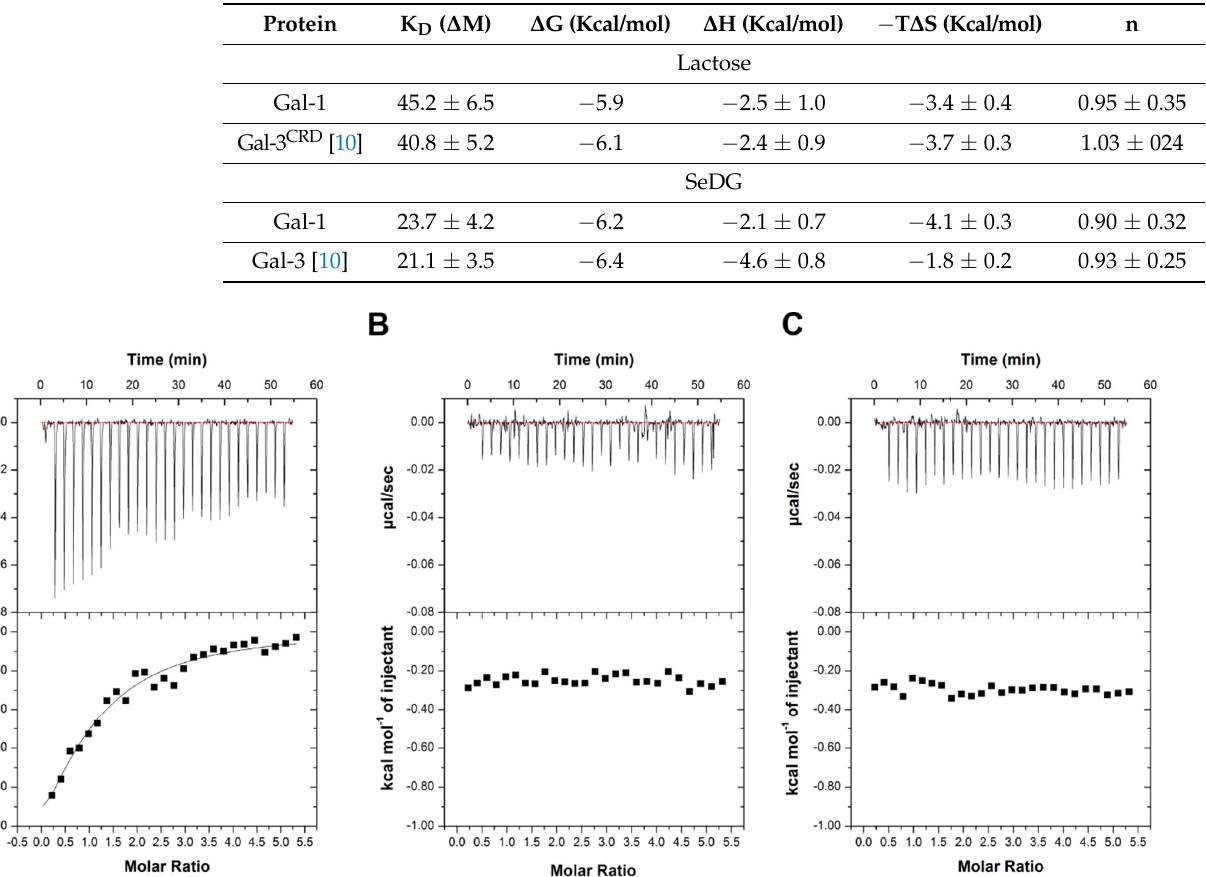
Figure 3. ITC binding studies on Gal-1. ( A ) Titration with SeDG and ( B ) with unsym(Se) in ( C ) the titration of buffer (negative control) is shown. The top panels of the graphs correspond to the injections while the bottom panels correspond to the integrations of the peaks according to the molar ratio of the tested molecules.